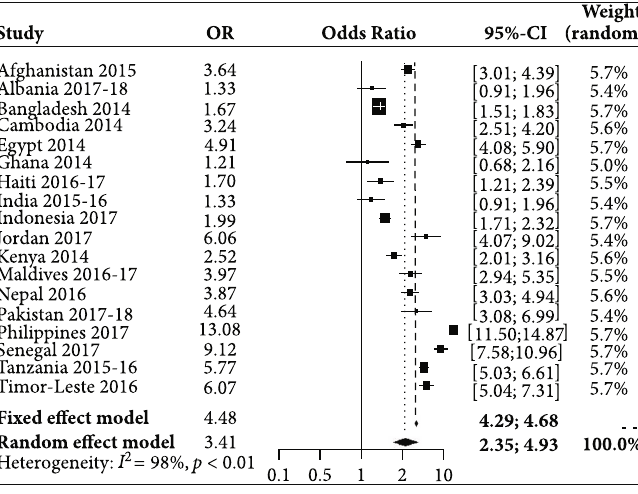
Figure 3: Forest plot for the variable respondent age.